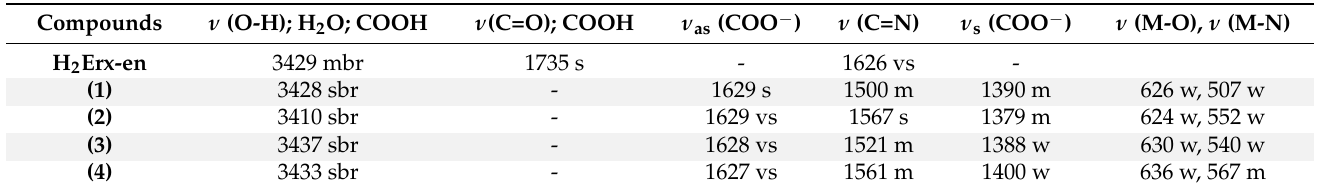
Table 2. Selected infrared wave numbers (cm − 1 ) for H 2 Erx-en and its metal complexes. Compounds ν (O-H); H 2 O; COOH